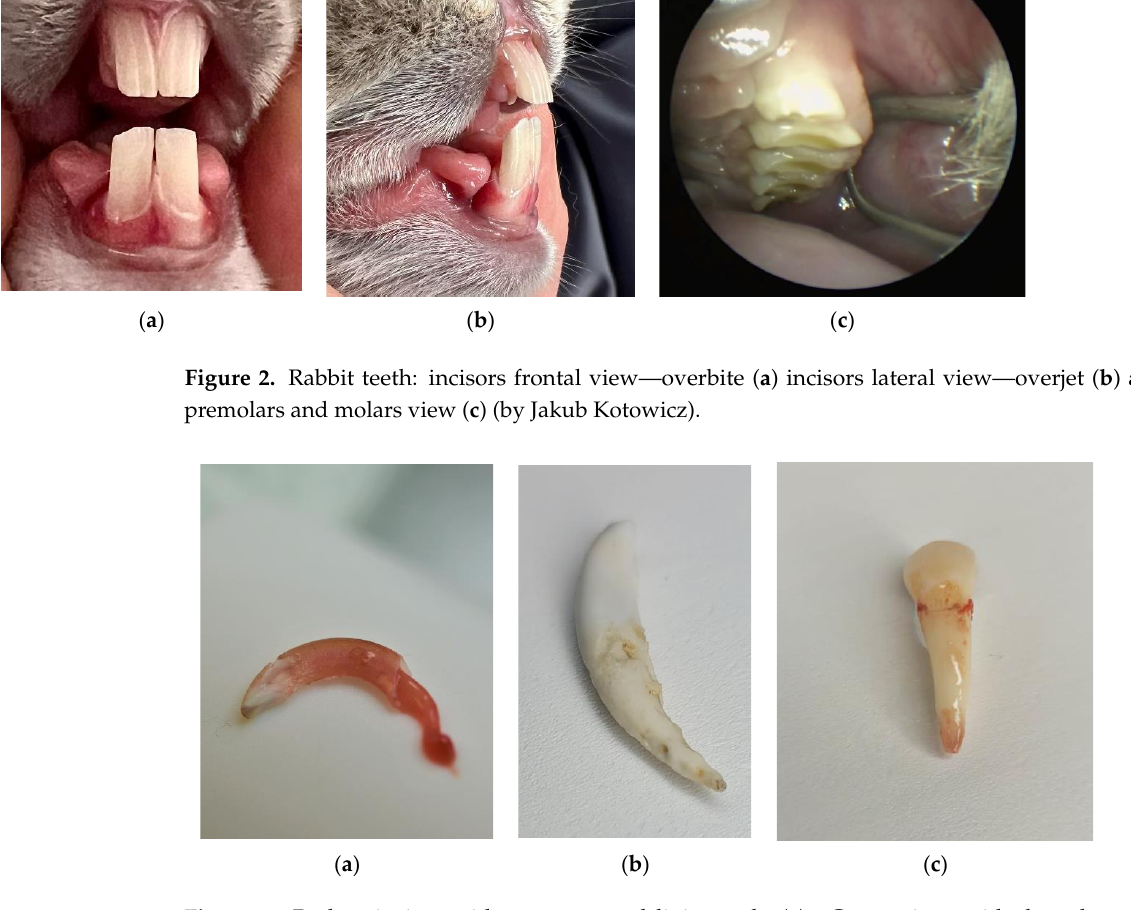
Figure 4. Anisognathism in rabbits: in 1:1 scale ( a ), enlarged ( b ) (by Małgorzata Peruga and Jakub Kotowicz). Choosing rats and rabbits as test animals to assess the tooth movement during either a menstrual cycle or the administration of hormonal contraceptives is also controversial due to the fact that the estrus of these animals is too short [15,19 – 25,27 – 29,32 – 35] (Table 2) to notice visible changes in the three-stage process caused by orthodontic forces. Moreo- ver, small animals do not match human biologically and do not live for long, not allowing for longitudinal studies. 6. Cats Celebi et al. [26] used the domestic cat as a research model in hormonal testing. How- ever, cats have no masticating surfaces (Figure 5a – c). The arrangement of their teeth in the dental arches and high degree of nodularity precludes using cats for orthodontic research, unless the bite is raised, which the authors did not mention describing their methodology (Table 2). Although cats are used as laboratory animals, due to the fact that their brain demonstrates the closest similarity to humans, these animals are primarily used in neuro- logical, ophthalmological, and immune deficiency research, and not in hormonal and or- thodontic studies.